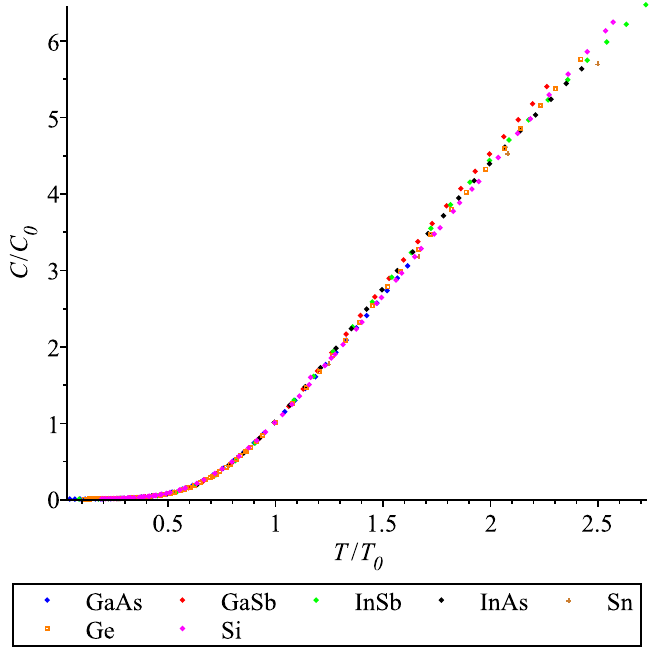
Figure 6. QLT regime of the rescaled specific heats of the diamond and zincblend lattice materials.